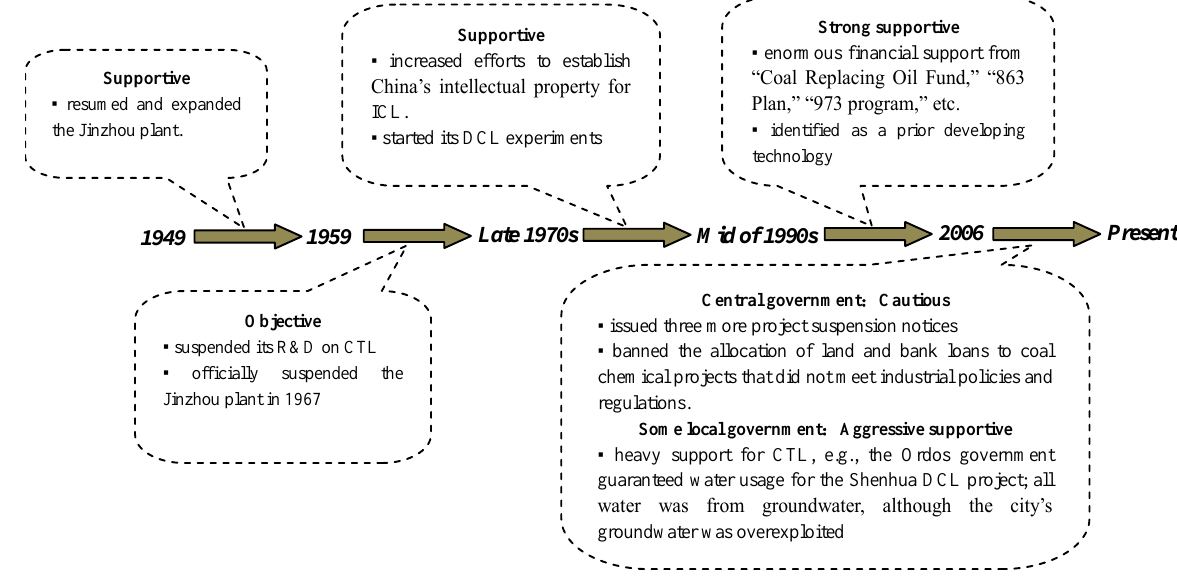
Figure 1. Key milestones in attitudes towards China’s coal liquefaction policy from 1949 through the